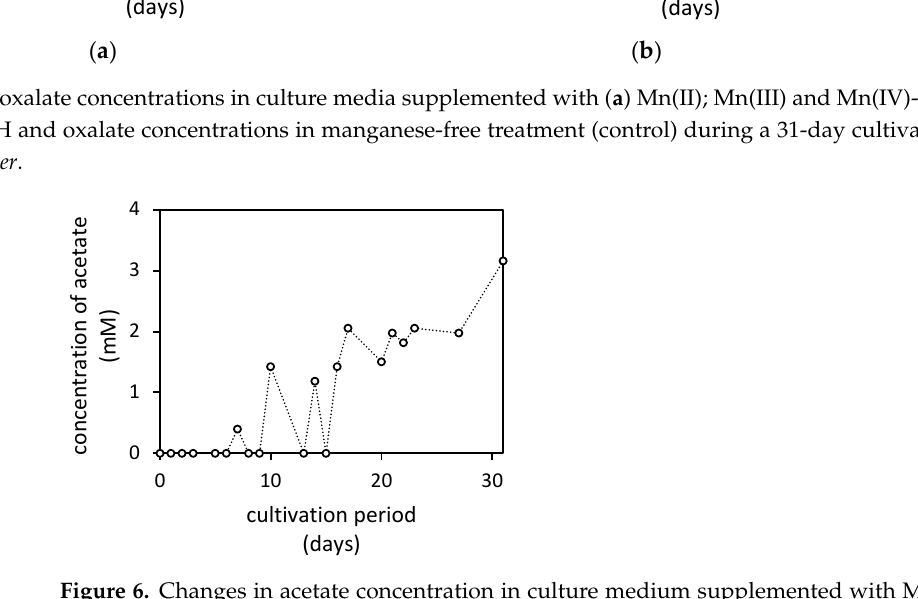
Figure 5. Changes of oxalate concentrations in culture media supplemented with ( a ) Mn(II); Mn(III) and Mn(IV)-oxides, and ( b ) changes of pH and oxalate concentrations in manganese-free treatment (control) during a 31-day cultivation of fungus Aspergillus niger .